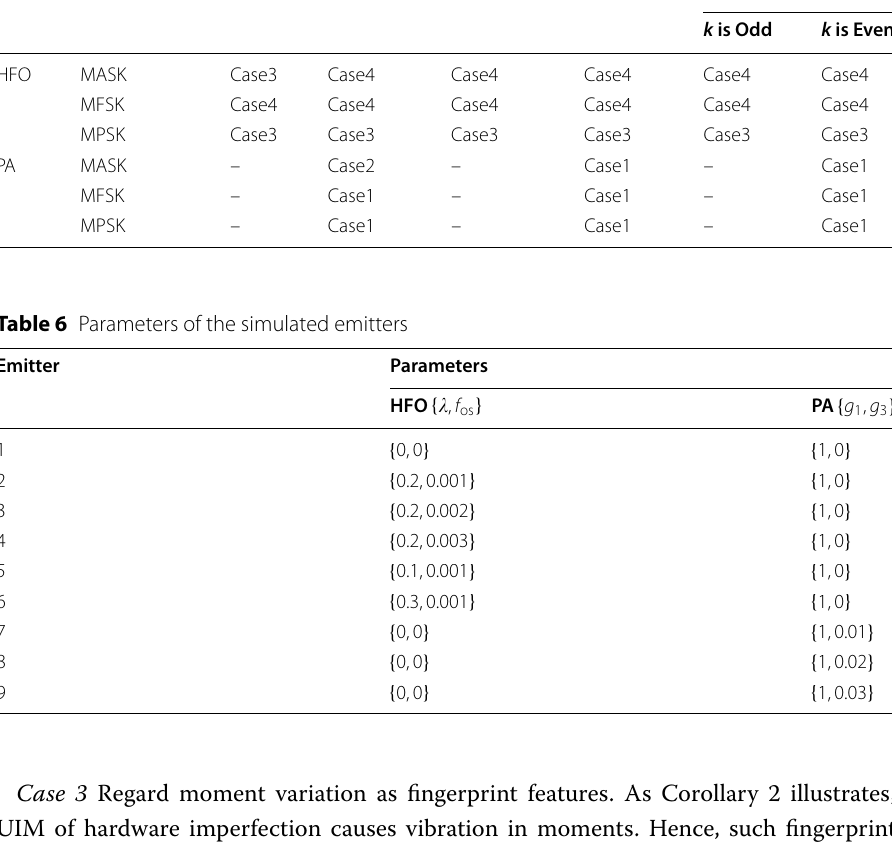
Table 5 Design fingerprint features for different cases UIM